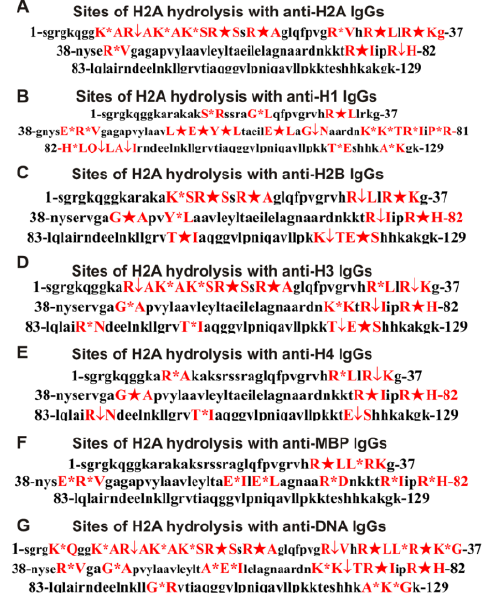
Figure 6. Sites of H2A hydrolysis by IgGs against H2A ( A ), H1 ( B ), H2B ( C ), H3 ( D ), H4 ( E ), MBP ( F ), and DNA ( G ). Major sites of H2A splitting are marked by big stars ( ★ ), moderate ones by arrows ( ↓ ), and minor sites of the cleavages by small stars (*) ( A – F ).